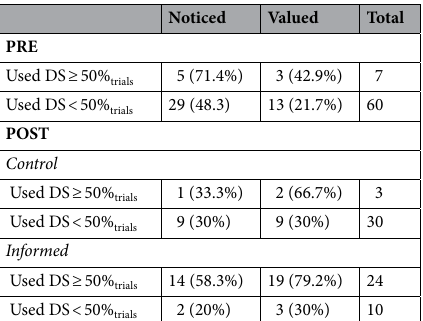
Table 1. Participants’ self-reports of noticing the difference between BASE and PROBE trials (noticed), and of ascribing importance to the Triangle (valued).